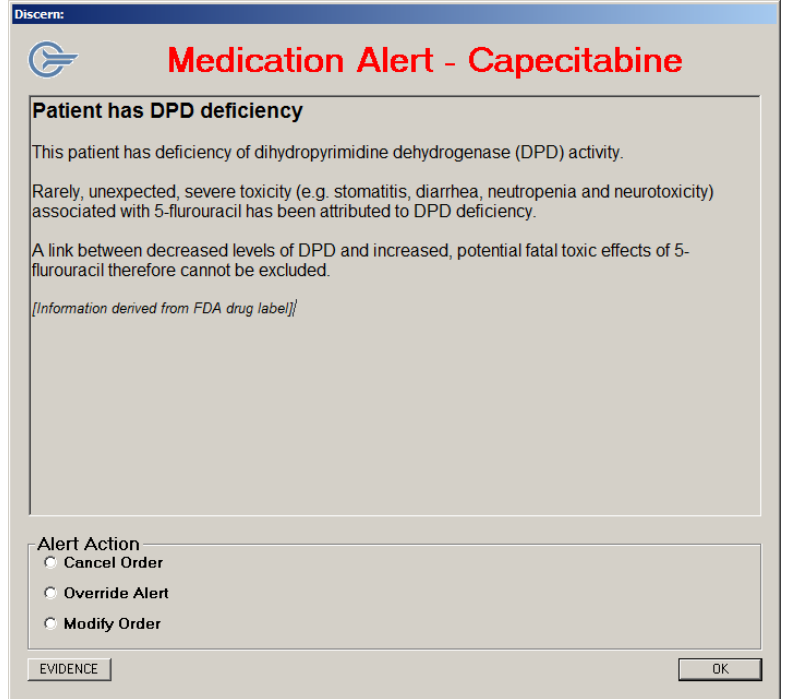
Figure 4. Example Cerner® alert